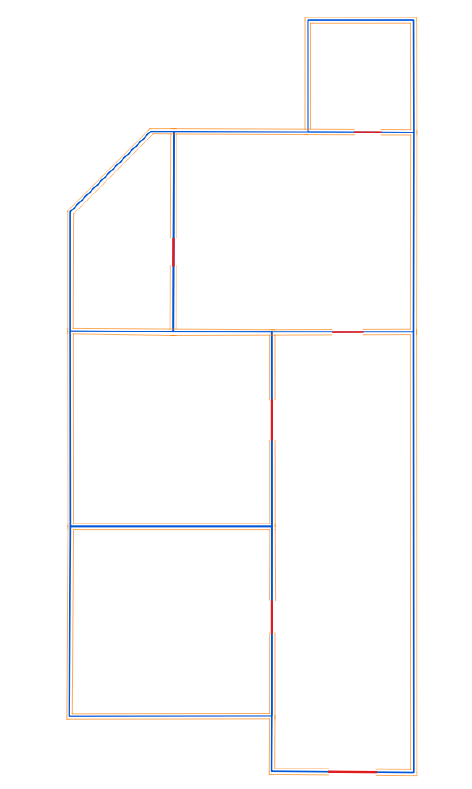
Figure 6. Output after wall and door extraction. The blue lines represent the wall extracted after centre line generation and red line segements represent the doors.